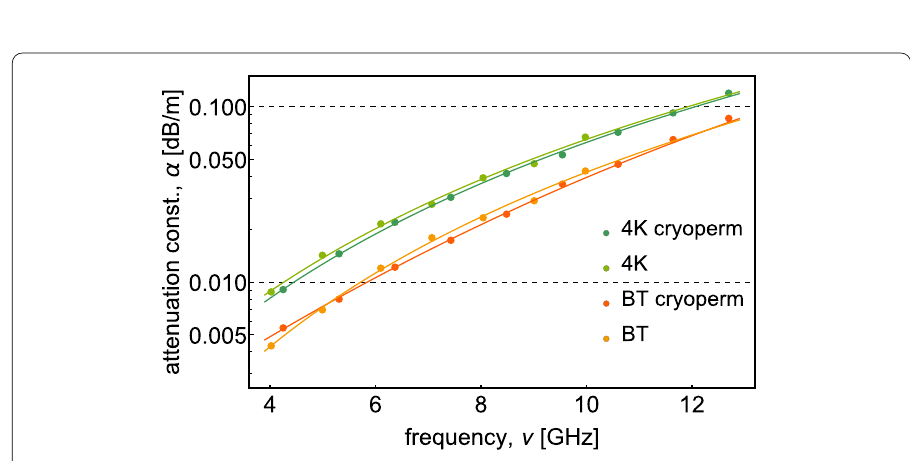
Figure 10 Attenuation constants extracted with and without magnetic shielding. Comparison of the attenuation constants measured at 4K and BT with and without cryoperm magnetic shielding for CC085NbTi. The solid lines are extracted from fits to the measured quality factors according to the model of Eq. (5).